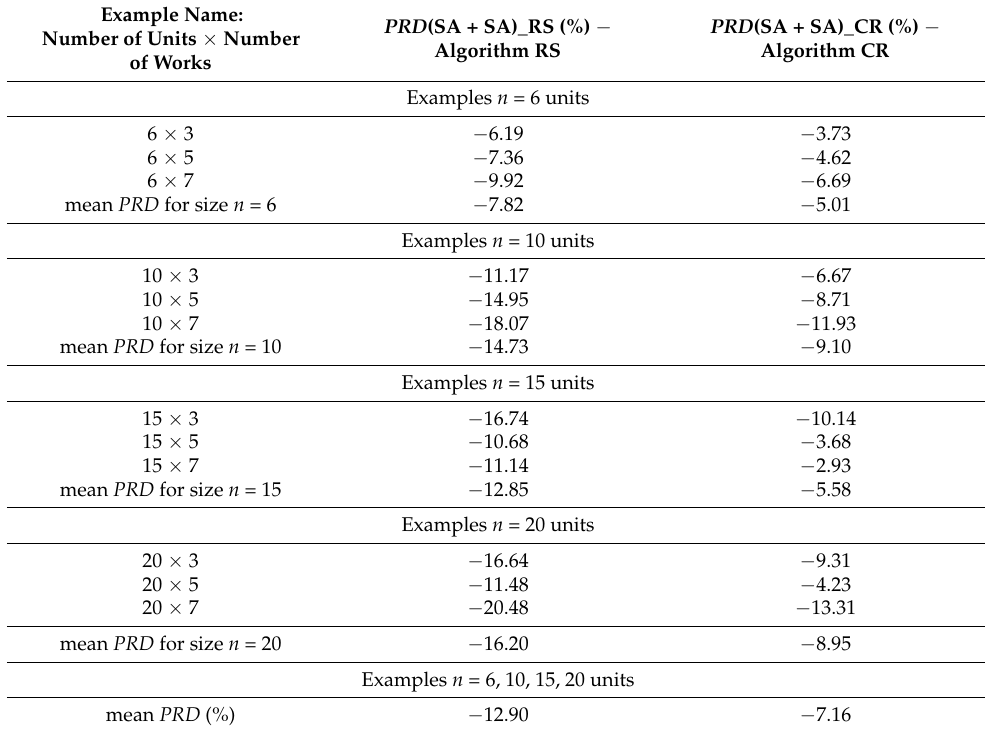
Table 1. The verification results for examples n = 6, 10, 15, and 20 units obtained with the use of the SA + SA